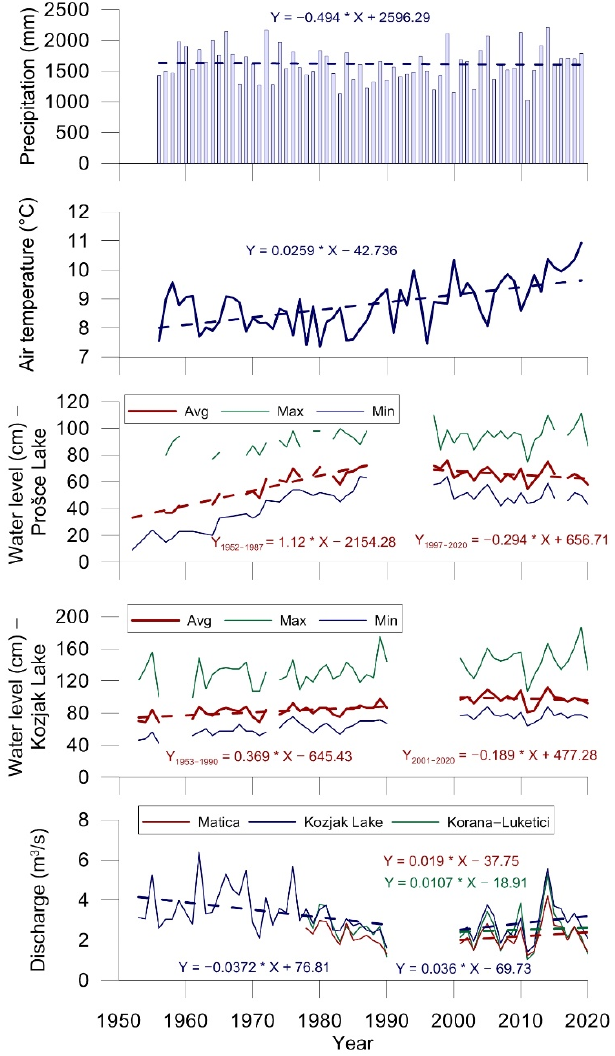
Figure 6. Course of the mean, minimum, and maximum annual water levels at the Proš ć e (1952–